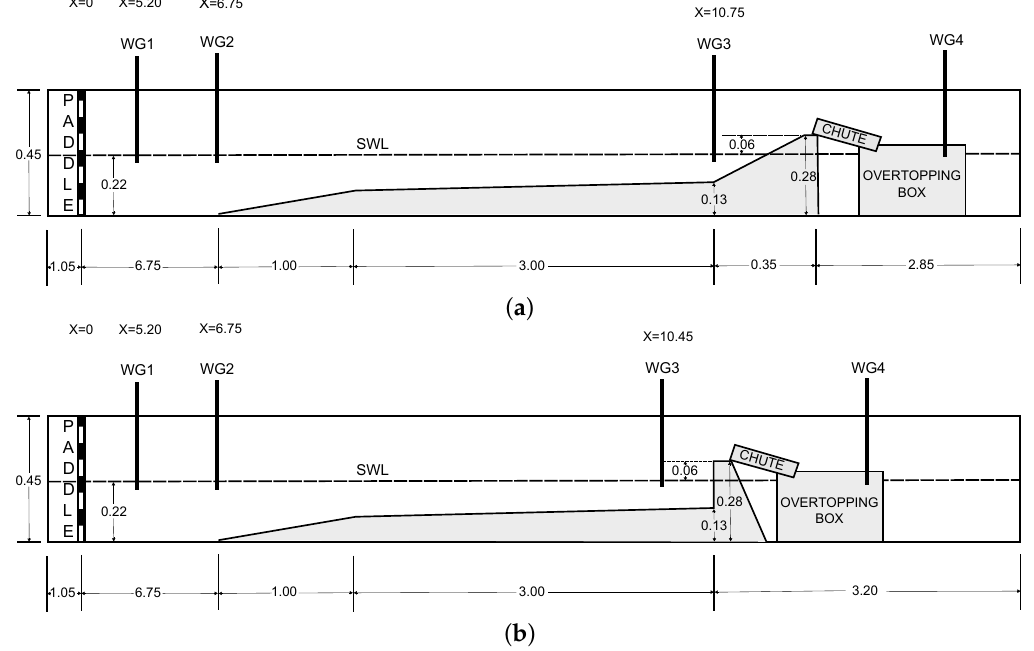
Figure 1. Indicative layouts of the physical models (not to scale). ( a ) smooth sloped structure; ( b ) vertical wall